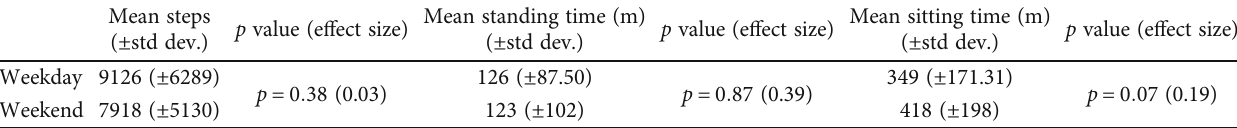
Table 5: Comparison between accelerometer recorded weekend and weekday daily steps, standing time (minutes), and sitting time (minutes) ( mean ± std dev : ).